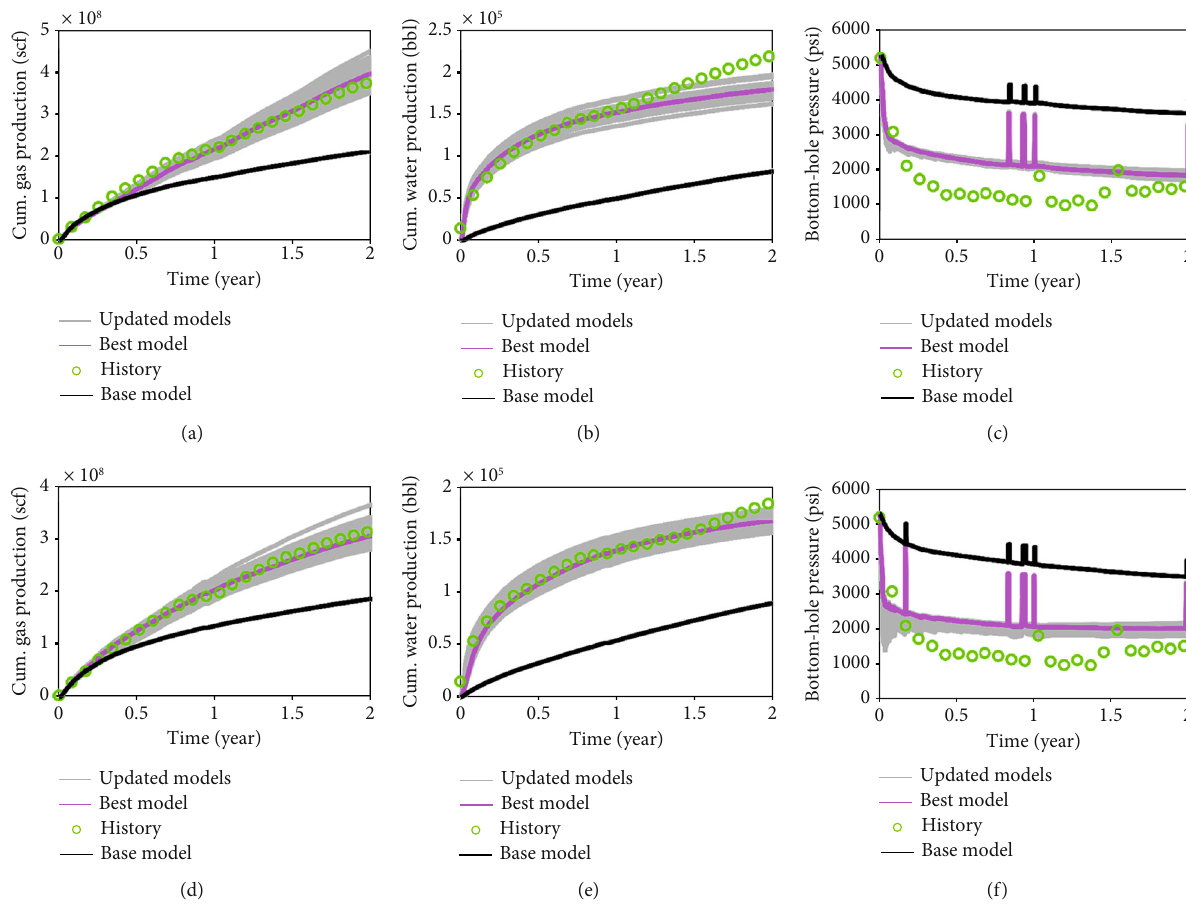
Figure 9: Two-year history matching simulation results: (a) cumulative gas production of well A, (b) cumulative water production of well A, (c) BHP of well A, (d) cumulative gas production of well B, (e) cumulative water production of well B, and (f) cumulative water production of well